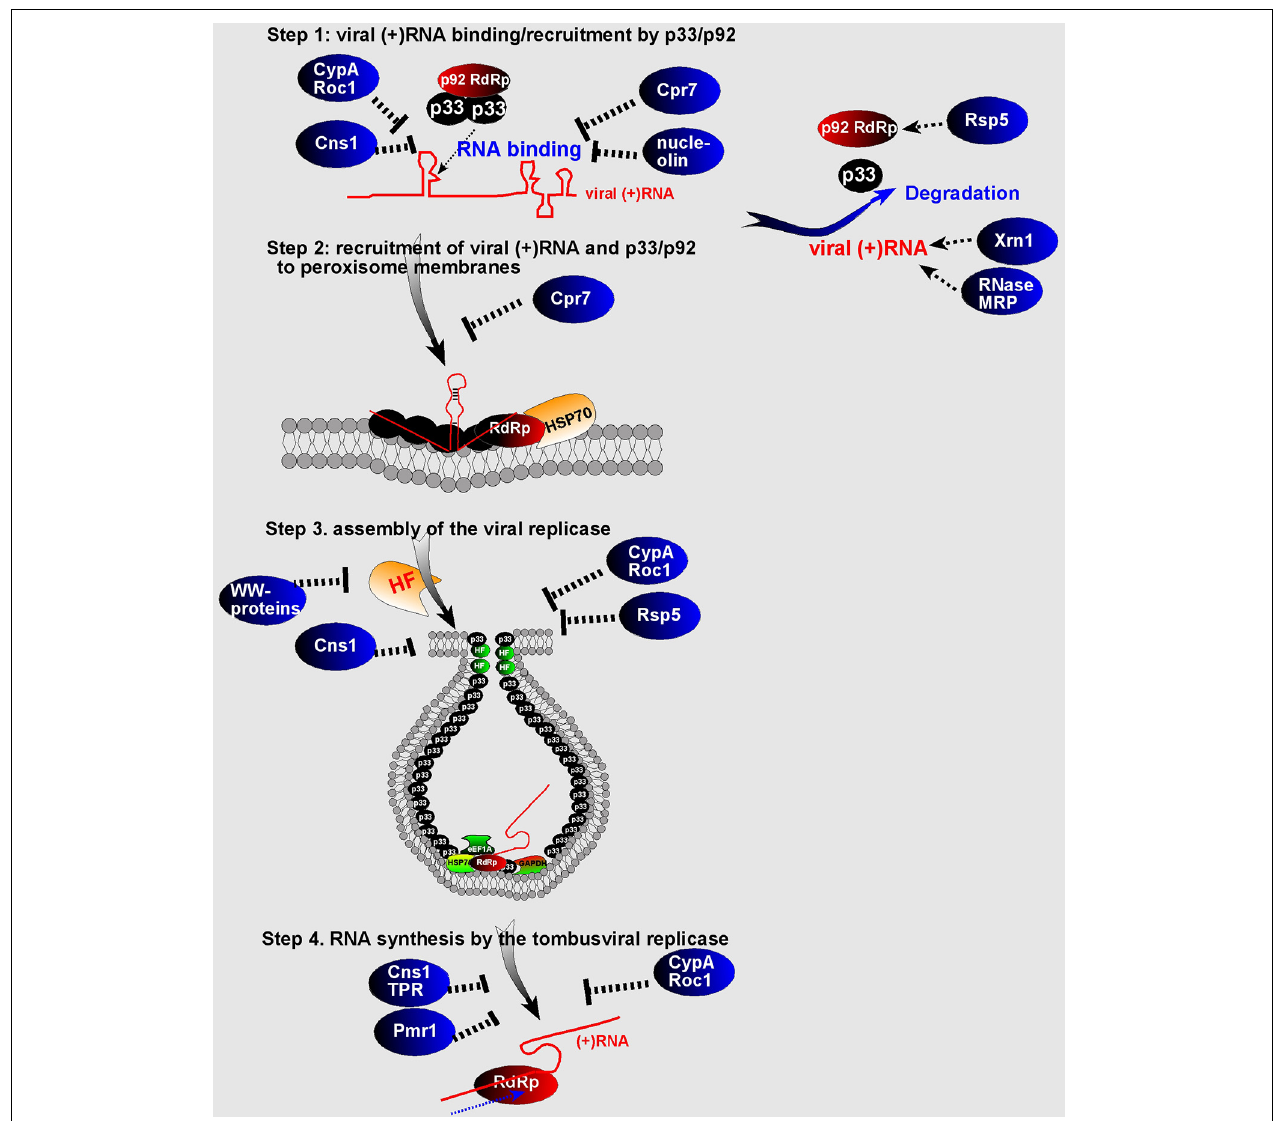
FIGURE 4 | Schematic presentation of the known or proposed roles of CIRFs in tombusvirus replication. The four steps of the TBSV replication and degradation of viral components (p33/p92 and the viral RNA) are shown.